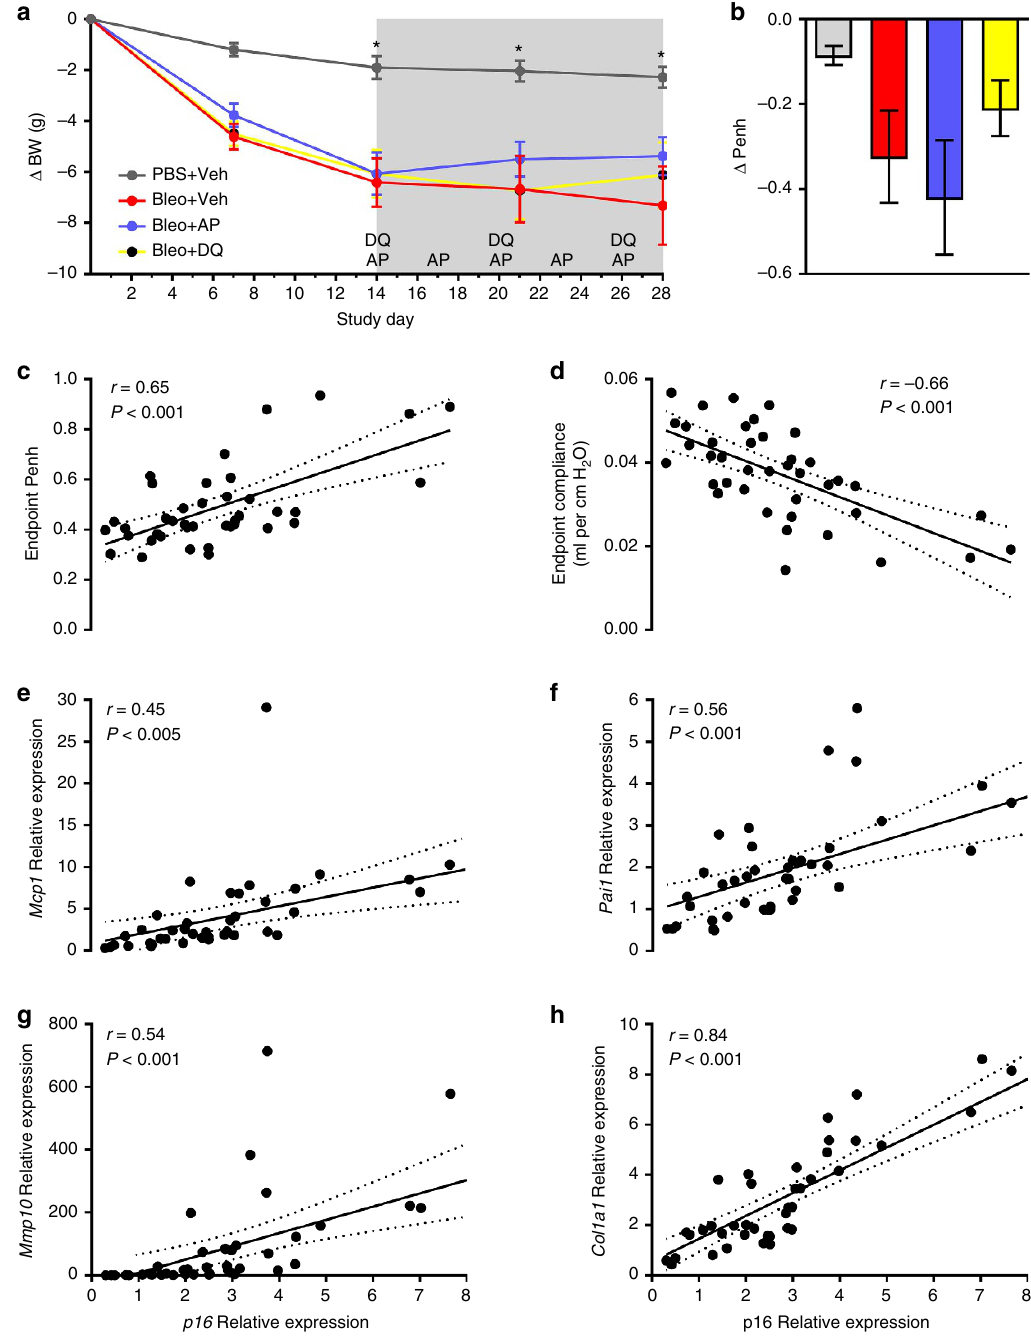
Figure 5 | Retention of p16-positive cells impedes resolution of bleomycin lung injury. ( a ) Ink-Attac transgenic mice receiving bleomycin (Bleo) through aerosolized intratracheal instillation were randomized to vehicle (Veh), AP or DQ and were compared with PBS-exposed, Veh-treated mice. Mice were treated as indicated from day 14–28 (grey shading). Body weight (BW) was monitored daily and is depicted as change in grams relative to baseline (* P o 0.05). ( b ) Endpoint (4 weeks post exposure) Penh levels were compared to Penh levels measured at treatment randomization (2 weeks post exposure). Lung p16 expression levels measured by RT–PCR (normalized to Hprt ) were compared with endpoint ( c ) Penh, ( d ) airway compliance, ( e ) Mcp1 , ( f ) Pai1 , ( g ) Mmp10 and ( h ) Col1a1 expression in bleomycin-injured mice (mean ± s.e.m.; PBS þ Veh n ¼ 6 (grey), Bleo þ Veh n ¼ 13